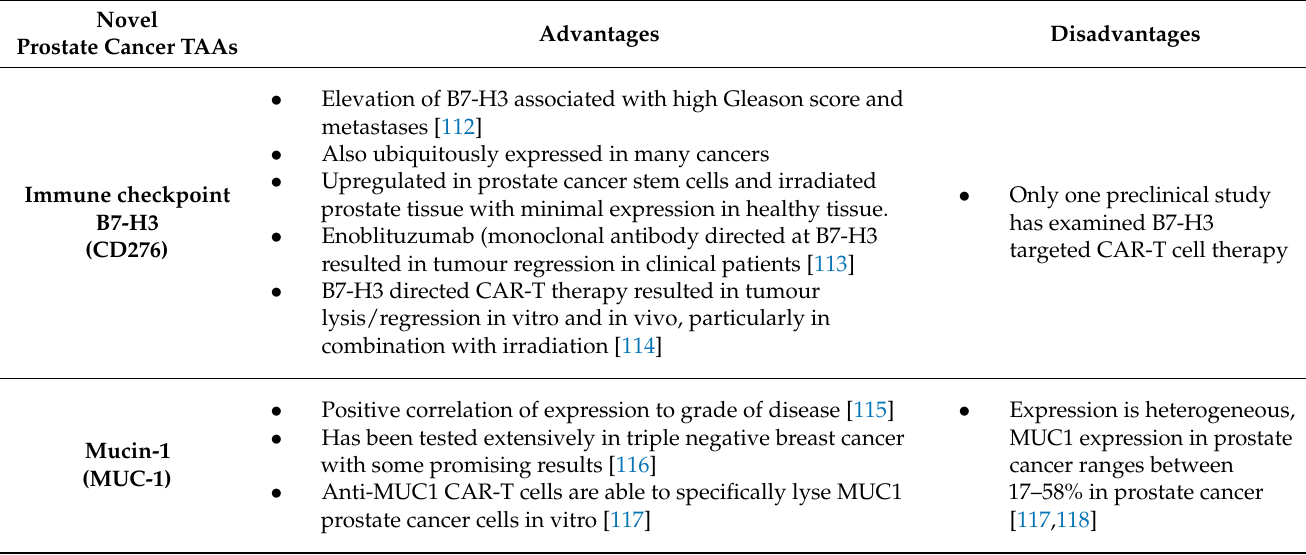
Table 4. Emerging novel cell surface targets for prostate cancer CAR-T